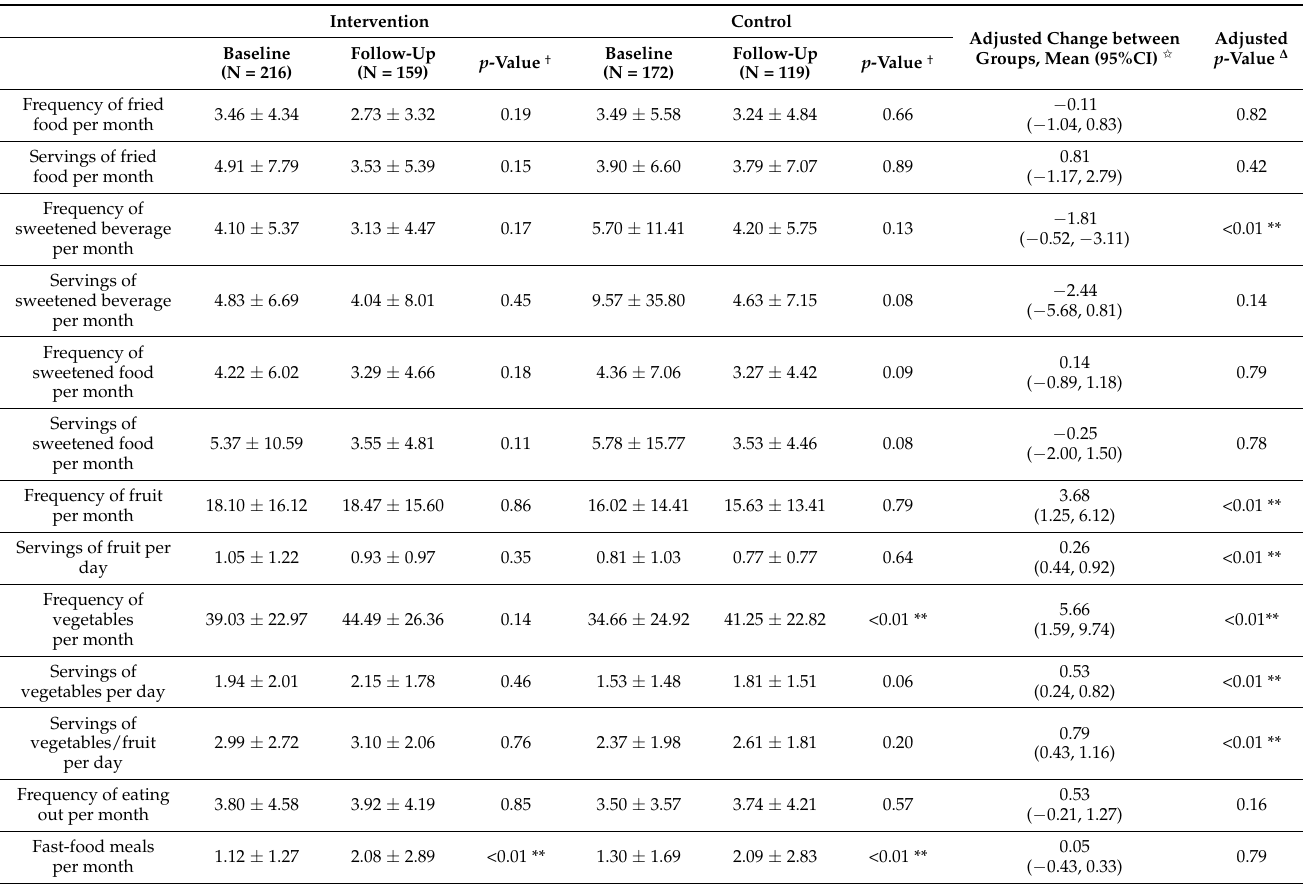
Adjusted p -Value ∆ Baseline